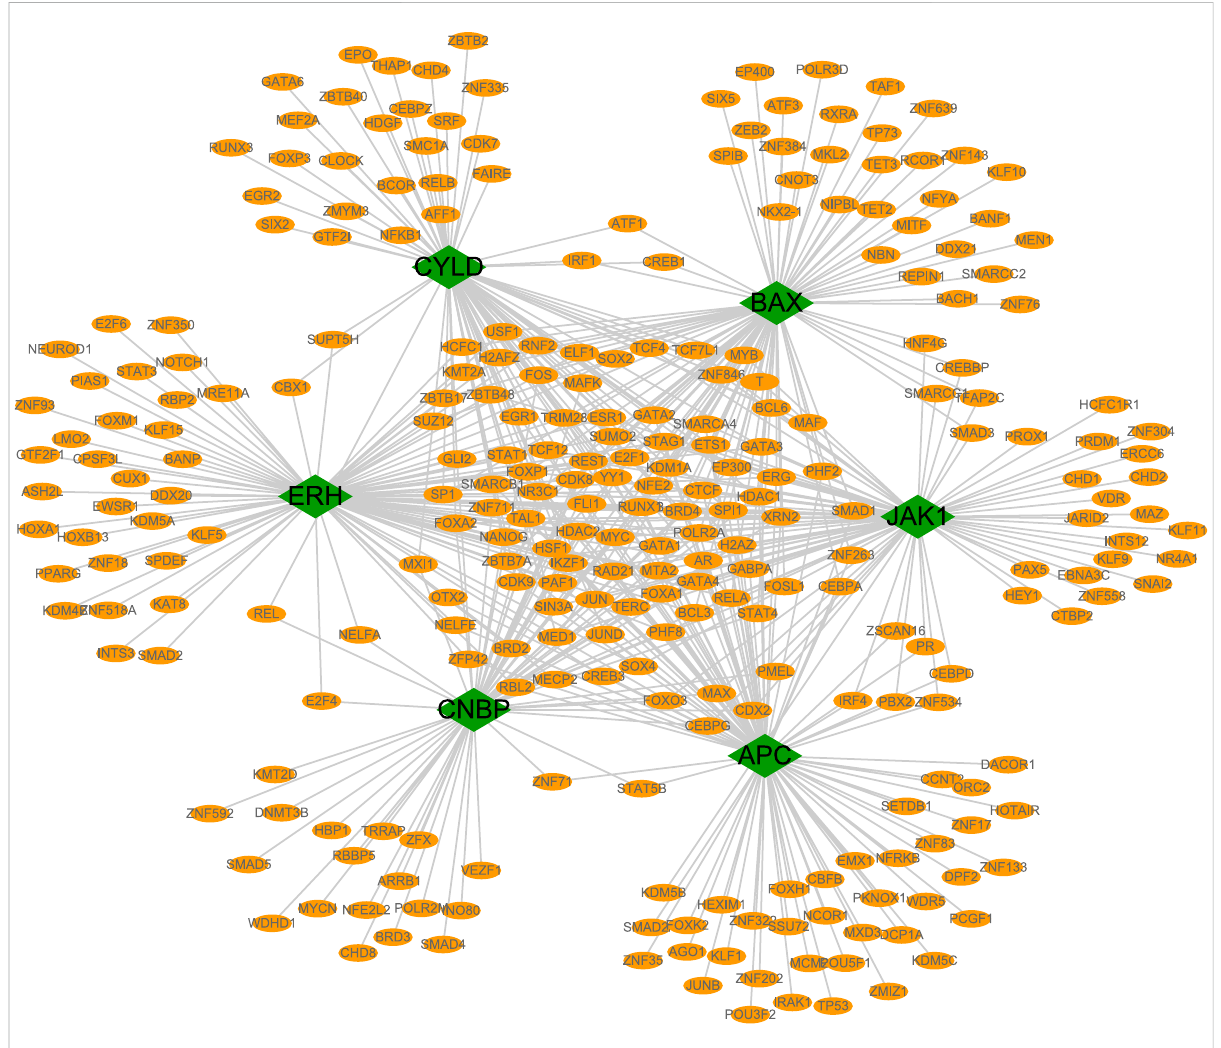
FIGURE 8 Transcriptionalregulatorynetworksofmodelgenes.Thetranscriptionalregulatorynetworkofcoregeneswasbasedoncistromedatabase,and the species was set as HG38, and the transcription start site was set as 10 KB. Green represents model genes and orange represents associated transcription